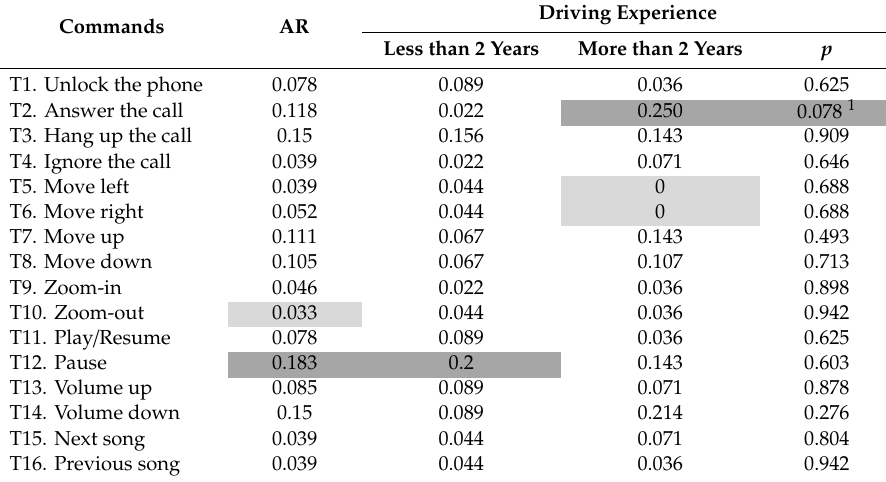
Table 2. Agreement rates (AR) for the 16 commands based on the participants’ driving experience. Commands with the highest AR are highlighted in dark gray while the lowest AR are shown in light